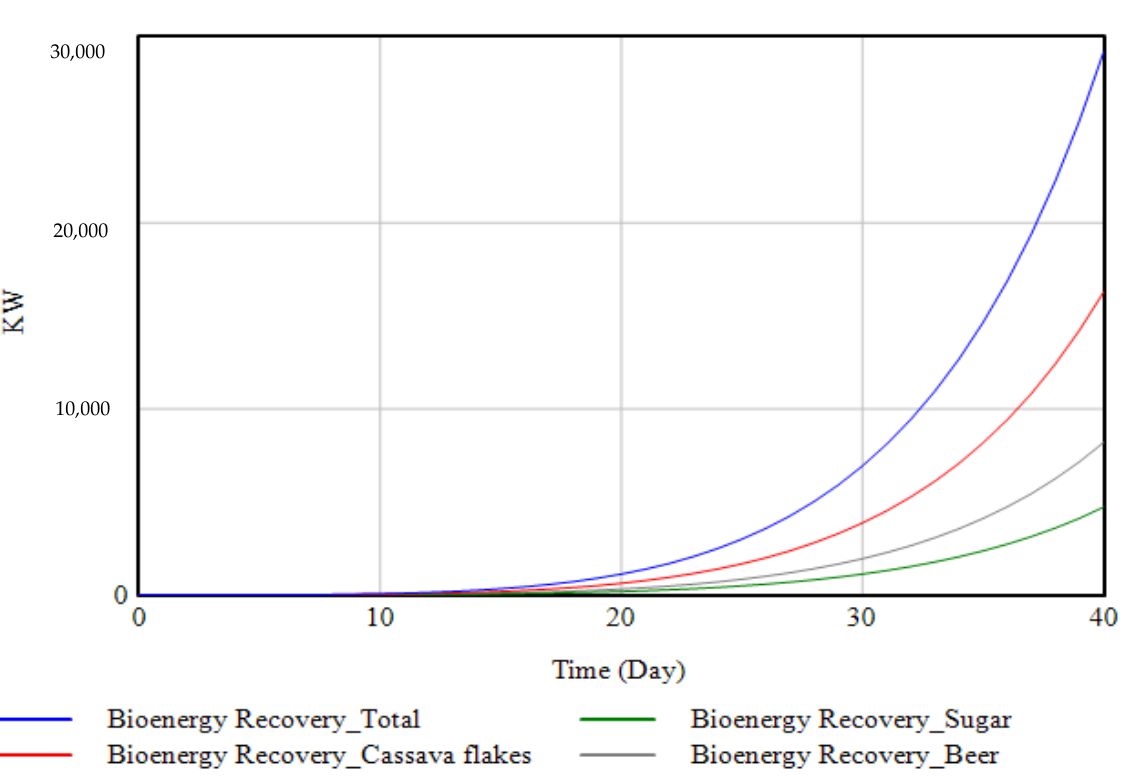
Figure 7. Heat and electrical energy potential from the biogas recovered from the effluents. Table 2 shows the total avoided emissions from the average daily electricity generated from the effluents. The table shows the average daily heat and electricity generation potential of each source of effluent and the equivalent avoided emissions yearly. The highest heat and electricity generation potential comes from the processing of cassava, with the least potential from that of sugar. The first step in the LCA is to estimate the energy recovery potential to handle the average daily methane generated from the effluents. The next is to estimate the power capacity of the generator for the potential energy recovered. This is then followed by the calculation of the avoided emissions or fossil fuel displaced when generating electricity and heat from the effluents.